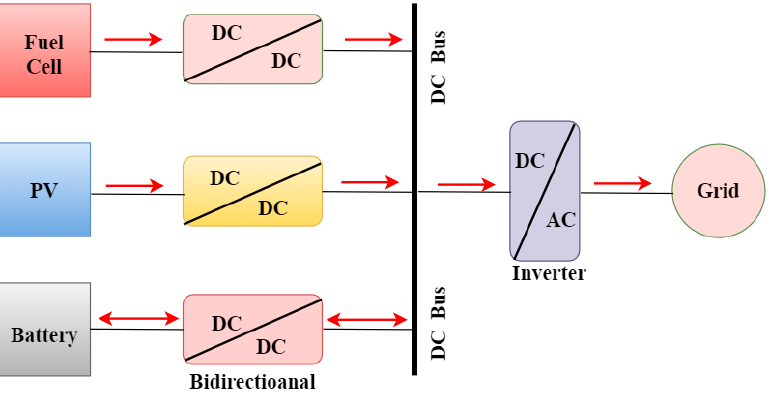
Figure 1. New energy technologies.